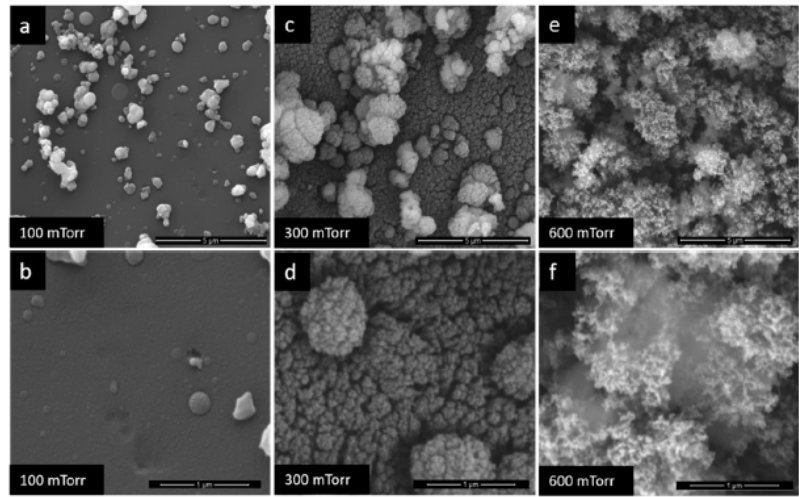
Figure 15. SEM images of TiO 2 films at ( a , b )—100 mTorr, ( c , d )—300 mTorr, ( e , f )—600 mTorr [122].